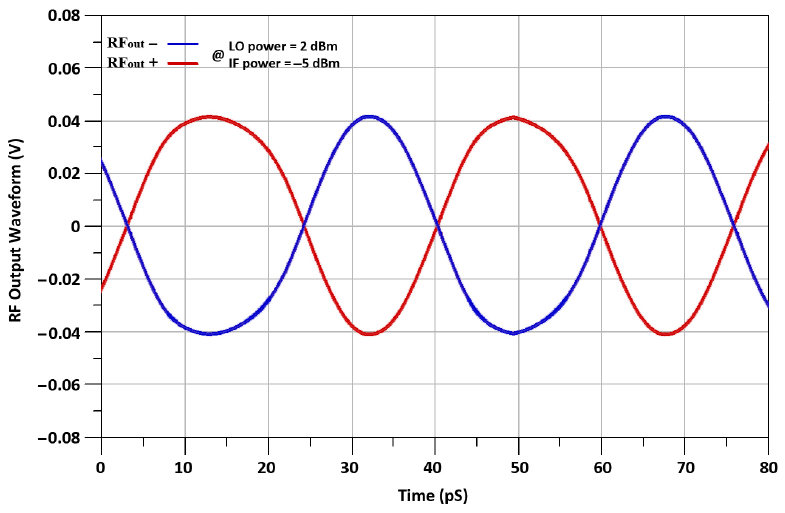
Figure 22. Output voltage waveform.